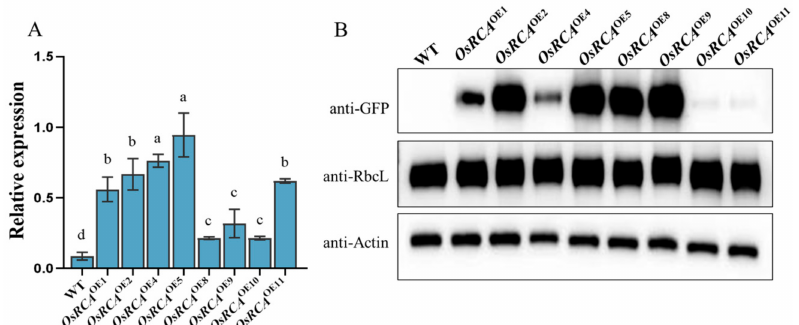
Figure 1. Molecular characterization of WT and OsRCA OE lines. ( A ) OsRCA mRNA abundance. The different letters indicate significant differences at p < 0.05. ( B ) OsRCA–GFP and RbcL protein expression. Anti–actin acted as an internal control to correct protein quantification. The fusion protein and RbcL protein were detected with Western blotting using anti–GFP and